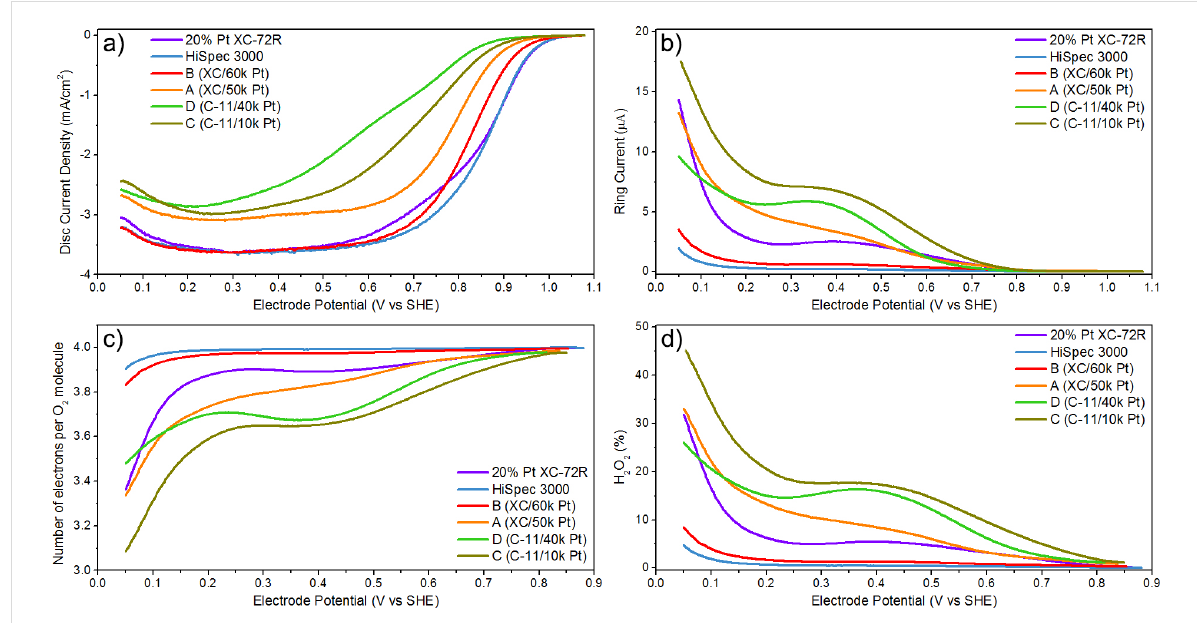
Figure 5: Curves recorded in the rotating disc electrode setup (at 900 rpm) for different Pt-based catalysts: (a) disc current density for the ORR, (b) corresponding limiting ring current at a fixed potential of 1.030 V, (c) number of electrons per O 2 molecule formed during the ORR, (d) %H 2 O 2 formed during the ORR. Curves (c) and (d) were calculated from the data in panels (a) and (b) using Equations 1 and 2, respectively, with η = 0.152 for 900 rpm. The thin film RRDE experiments were done in a four-electrode arrangement in 0.5 M H 2 SO 4 solution oxygenated with pure O 2 at 20 °C and 1 bar O 2 , with a potential scan rate of 5 mV/s.